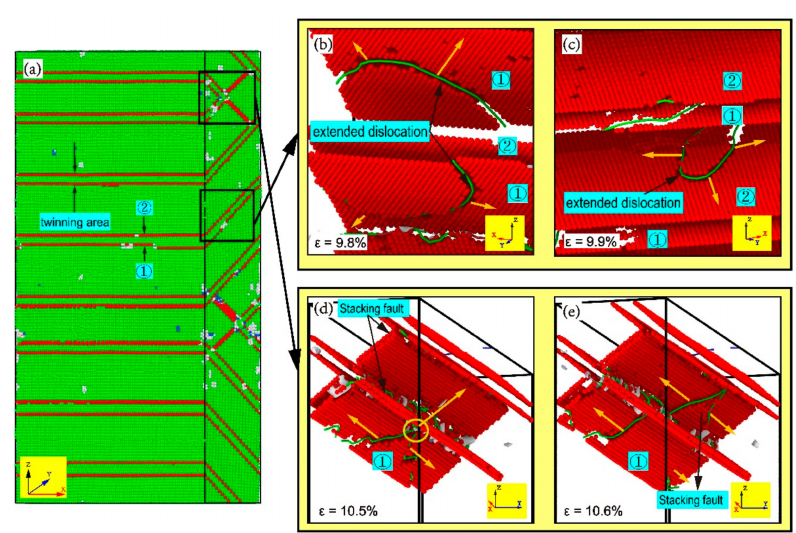
Figure 15. ( a ) The common neighbor analysis (CNA) of the model with α = 90 ◦ and dislocation analysis (DXA) of the model with α = 90 ◦ under di ff erent strain ε : ( b ) ε = 9.8%, ( c ) ε = 9.9%, ( d ) ε = 10.5%, and ( e ) ε = 10.6%.